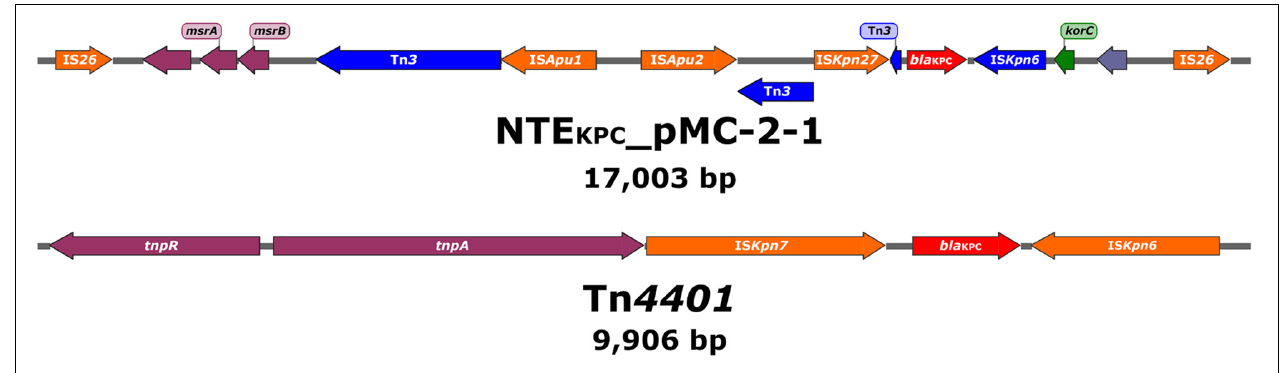
FIGURE 4 | Schematic drawing showing the genetic elements surrounding the bla KPC genes in the NTE KPC -pMC-2-1 variant and Tn 4401 , respectively. Arrows are oriented in the direction of transcription. Red arrows show the bla KPC gene, orange arrows represent full-length insertion sequences (IS), dark blue arrows represent partial or truncated transposon-related regions and ISs, and green arrows indicate genes involved in gene regulation. Blue-gray arrows show putative or hypothetical genes and plum arrows show genes involved in other